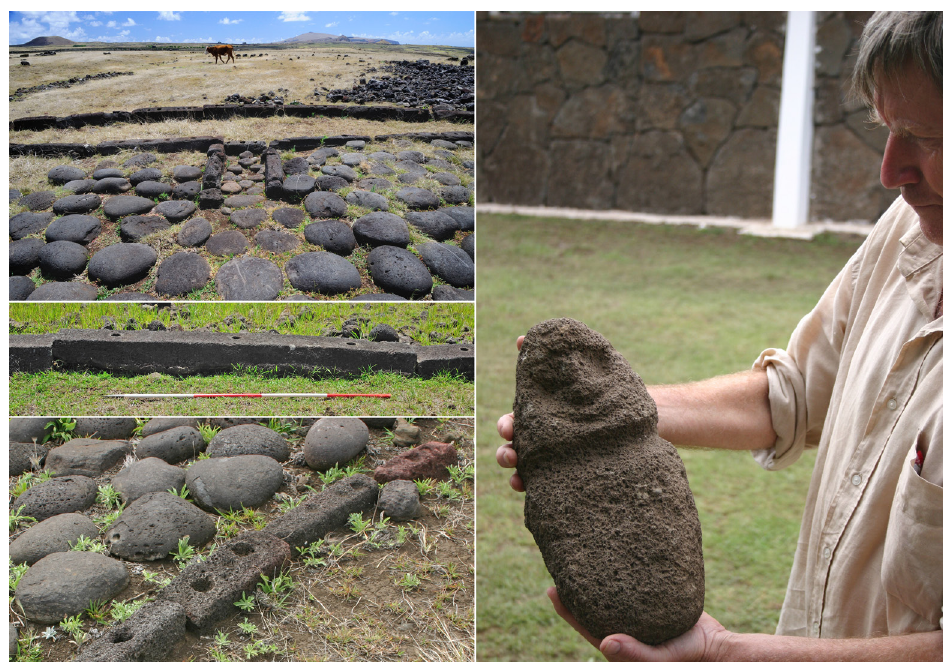
Fig. 9: Hare paenga (canoe-shaped houses). Clockwise from top left: lay-out of the stone base of hare paenga (photo: A. Stanford); Mike Seager Thomas with one of the ‘house gods’ in the Island’s museum (MAPSE) store; and two hare paenga foundations comprising the foundation stones of several former hare paenga (photos: M. Seager